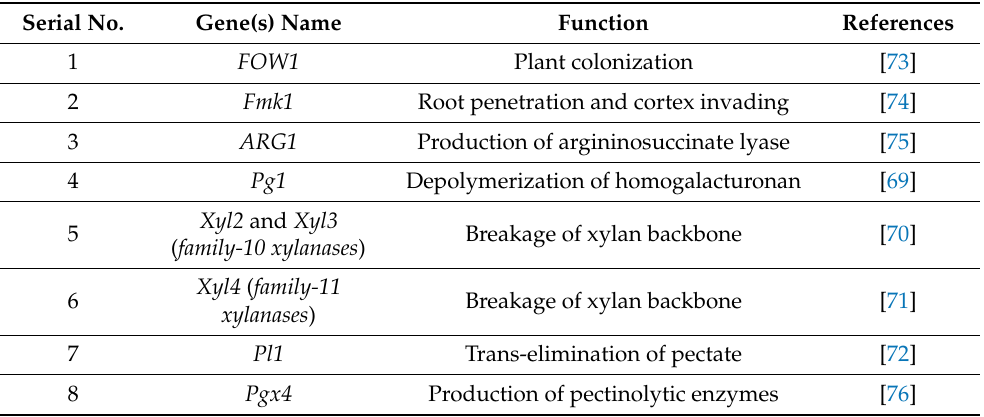
Table 4. List of genes related to pathogenicity. Serial